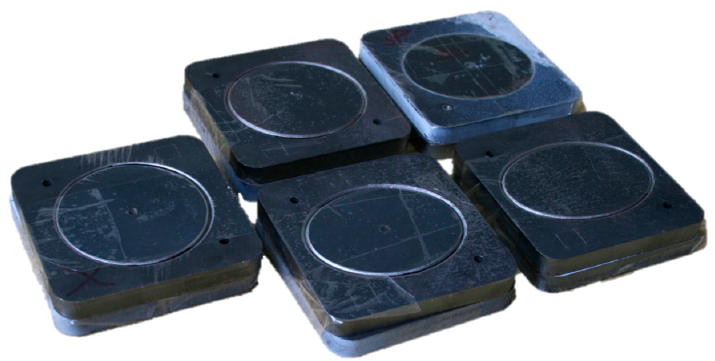
Figure 9. Manufactured variants of mechanical fixtures.